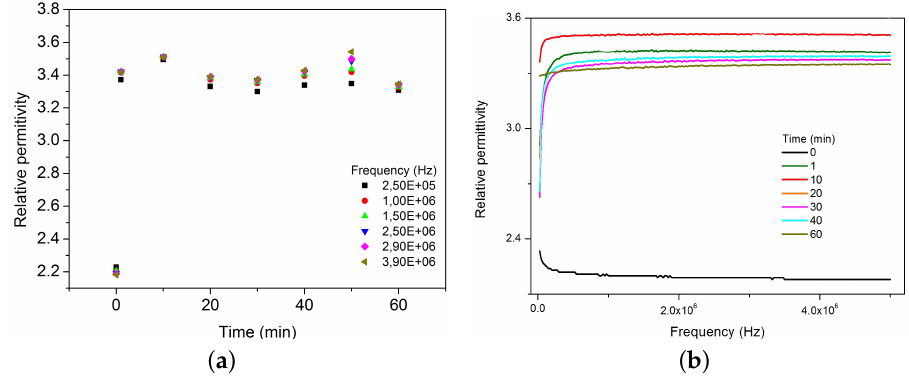
Figure 5. Time effect on CA’s behavior when 0.7 M NaCl solutions are added at specific frequencies. ( a ) Relative permittivity vs Time, regarding specific frequencies and ( b ) Relative permittivity vs. Frequency, regarding time. At 0 min the CA was